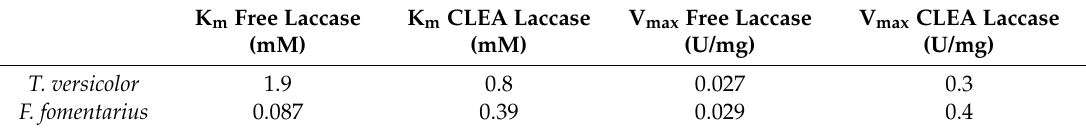
Table 2. Kinetic parameters of free and CLEA